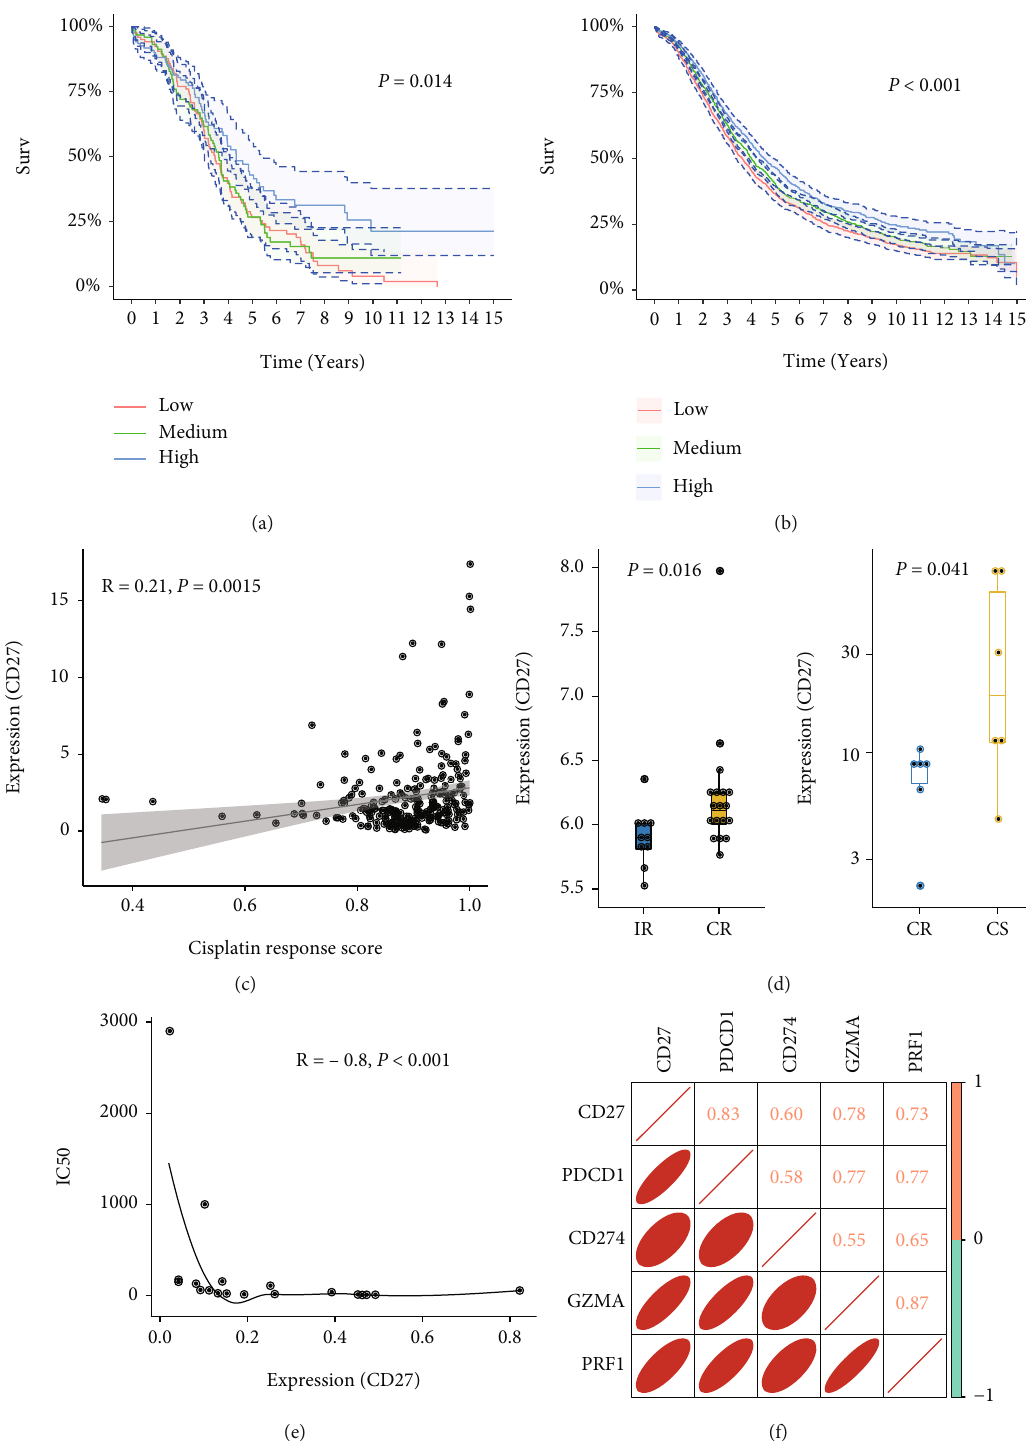
Figure 7: The association of CD27 expression with cisplatin response. (a, b) KMplot showed the overall survival rates of high-, medium-, and low-expression groups in TCGA and GSE135820 datasets. (c) The correlation of CD27 expression with cisplatin response scores. The Spearman rho statistic and the corresponding p value were estimated. (d) The expression values of CD27 between cisplatin response and nonresponse groups in the GSE23554 (left) and GSE148392 (right) datasets. (e) The correlation of CD27 expression with IC50 values on 19 OV cell lines. The Spearman rho statistic and the corresponding p value were estimated. (f) The correlation matrix showed the correlations of CD27 expression with the four genes, PDCD1, CD274, GZMA, and